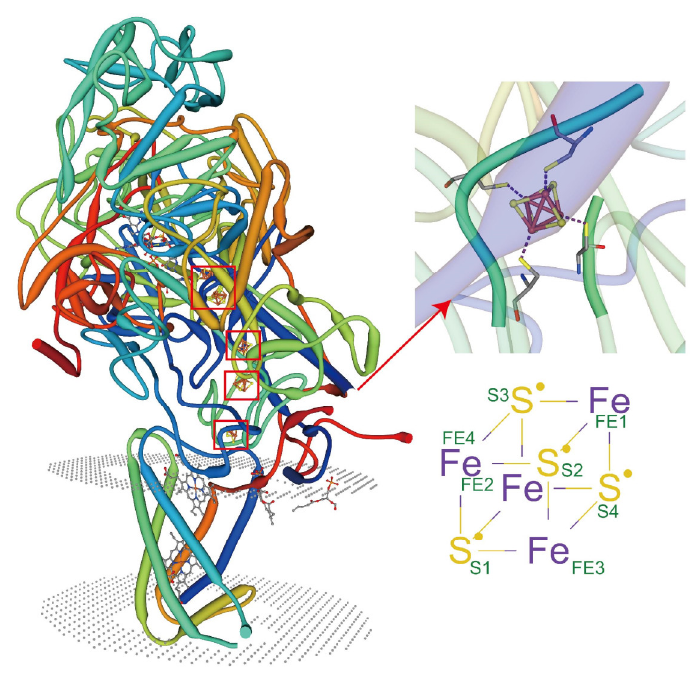
Figure 8. Lipids regulate the coordination of metal ions with membrane proteins. PDB ID: 3IR5, X-ray diffraction, 2.30 Å. Crystal structure of NarGHI mutant NarG-H49C in Escherichia coli . Tightly bound lipids exist between the transmembrane helices, while head groups bind in pockets composed of three subunits, and many positively charged residues participate in the binding.